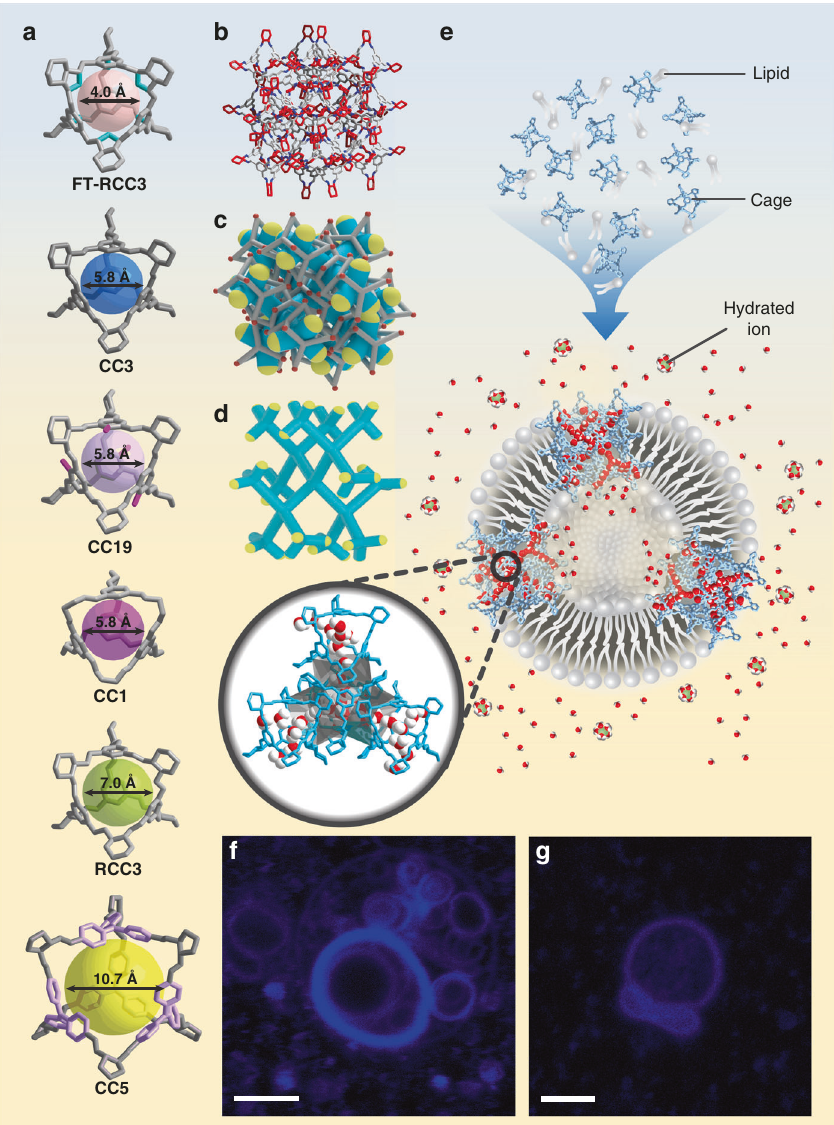
Fig. 1 POCs and POC nanoaggregates in liposome. a Crystal structures of FT-RCC3, CC3, CC19, CC1, RCC3, and CC5. b Structure of window-to-window packing of tetrahedral POCs. c Side view of a tetrahedral POC crystal (gray with red vertex group) with channel network (blue) shown. Ends of the channel network (yellow) are possible entry points for guest molecules. d Structure of an extended channel network without tetrahedral POC shell. The tetrahedral 3D channels run through cage cavities and inter-cage gaps with the node at the center of the cage cavity. e Scheme of CC3 nanoaggregates (light blue) in lipid bilayer with water chains formed inside the channels. Insert: CC3 molecules shown in blue with the water channel illustrated in gray. Fluorescence confocal microscopy of liposomes with CC5 ( f ) and CC19 ( g ) under an excitation of 402 nm laser. Blue circles indicate the presence of CC5 and CC19 in the lipid bilayer. Scale bar represents 5 μ